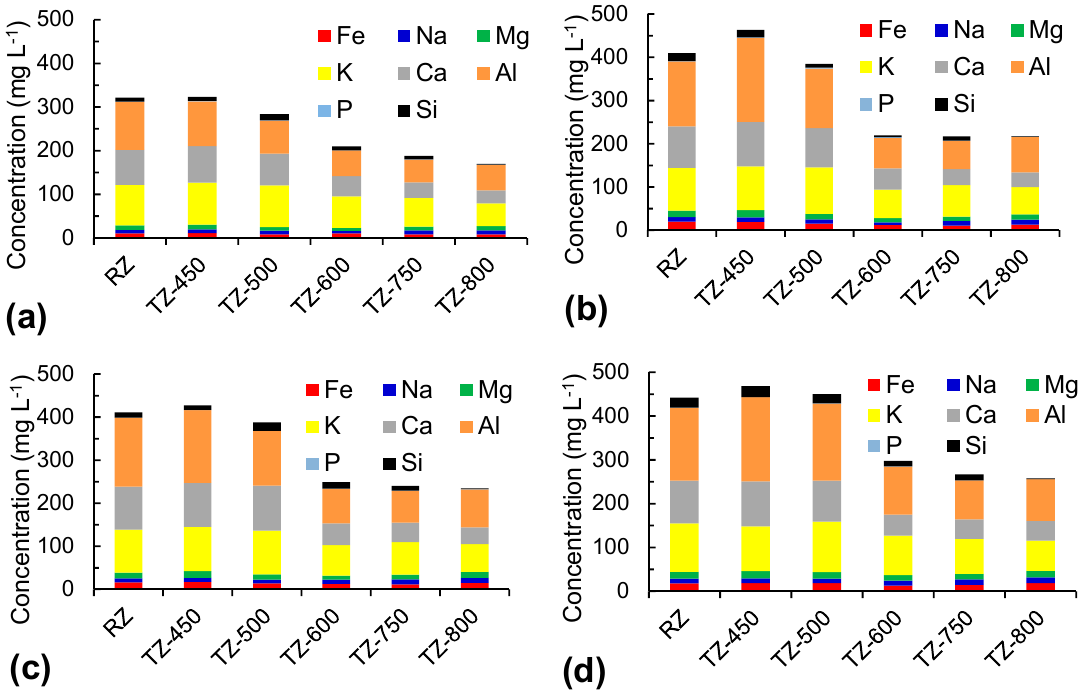
Figure 3. Influence of the thermal treatment temperature on element dissolution with a 10:1 ( w : v ) zeolite:simulated gastric fluid (SGF) ratio for exposure times of ( a ) 1 day, ( b ) 3 days, ( c ) 5 days, and ( d ) 7 days.